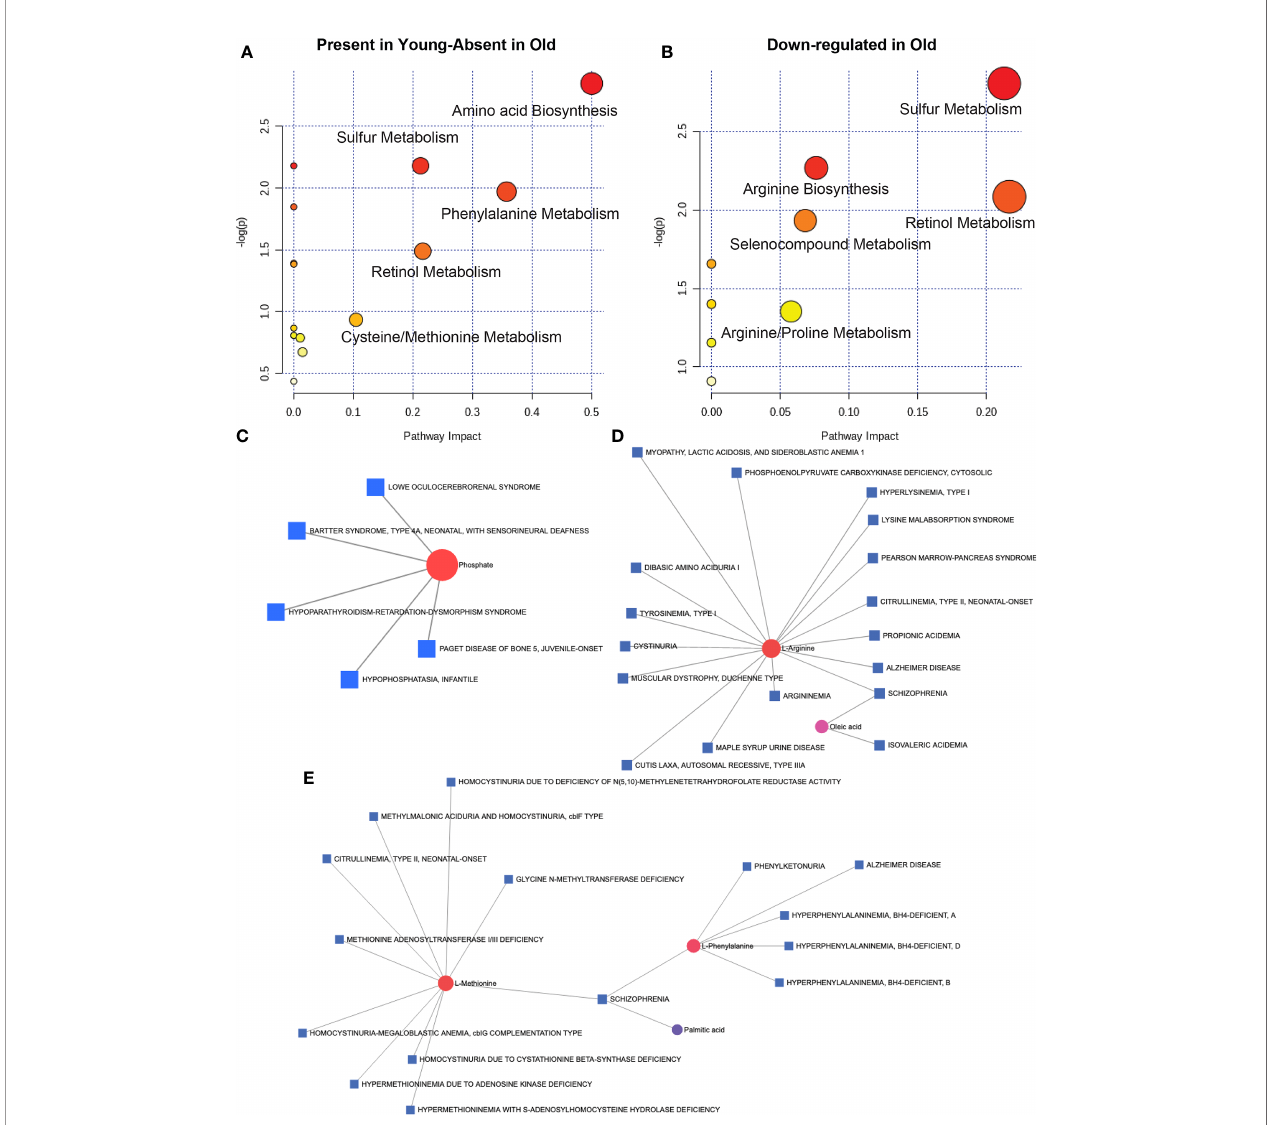
FIGURE 8 | Microbial metabolites and host disease pathways: In the microbe-free fecal compartment, after adjusting for diet-derived metabolites, several metabolites were signi fi cantly altered, that were mapped to several pathways in the aged animals. When all signi fi cantly changing metabolites in geriatric and young adult animals were mapped for human pathway impact (MetaboAnalyst 4.0),secondary metabolite synthesis, nucleotide synthesis and amino acid synthesis and degradation were still at synchrony with bacterial and host metabolic status for metabolites either absent (A) or down-regulated (B) in the microbial complement in geriatric animals (also see Supplementary Table 1 ). Metabolite-disease interaction network mapping identi fi ed several human diseases, mostly centered around alteration in Phosphate (C) , L-Argenine/Oleic acid (D) and L-Methionine/L-Phenylalanine (E) metabolism. All metabolites used in the analysis were signi fi cantly different between young adult and geriatric animals with FDR of 0.1 (Benjamini-Hochberg